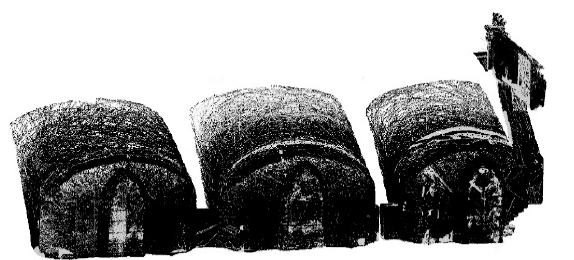
Figure 6. The ZEB1 point cloud, 18.602.477 points, 300